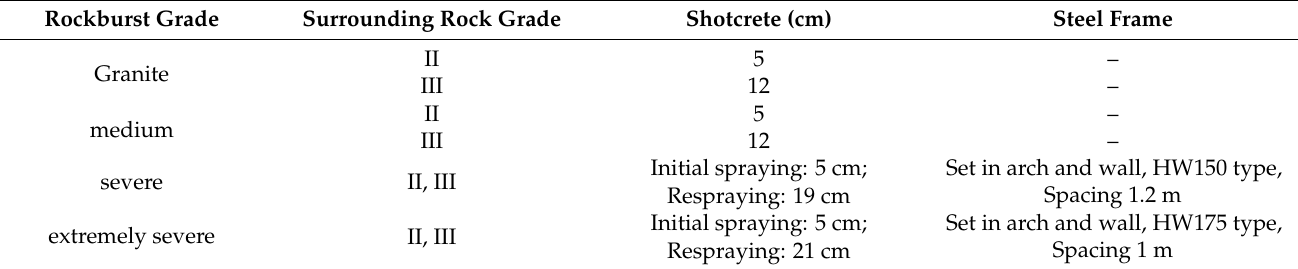
Table 10. Supporting parameters of the rockburst section in double-track by drilling and blasting method.